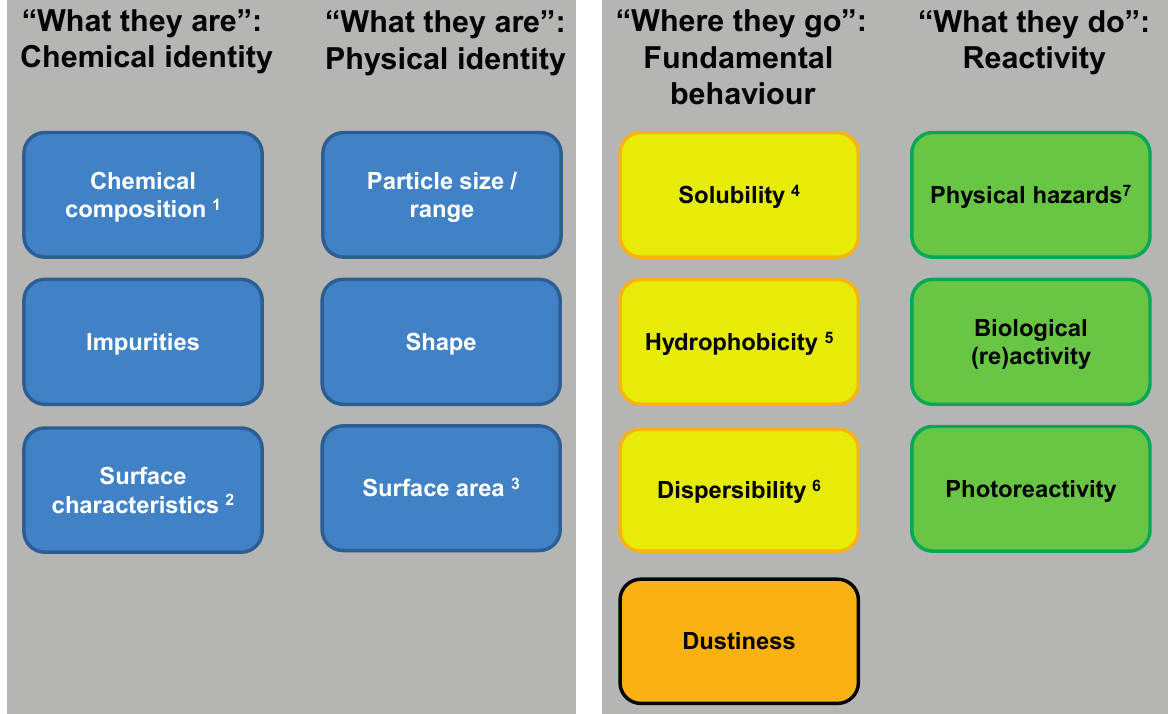
Figure 1. Key properties that characterize a NM (adapted from Seller et al . [1]),